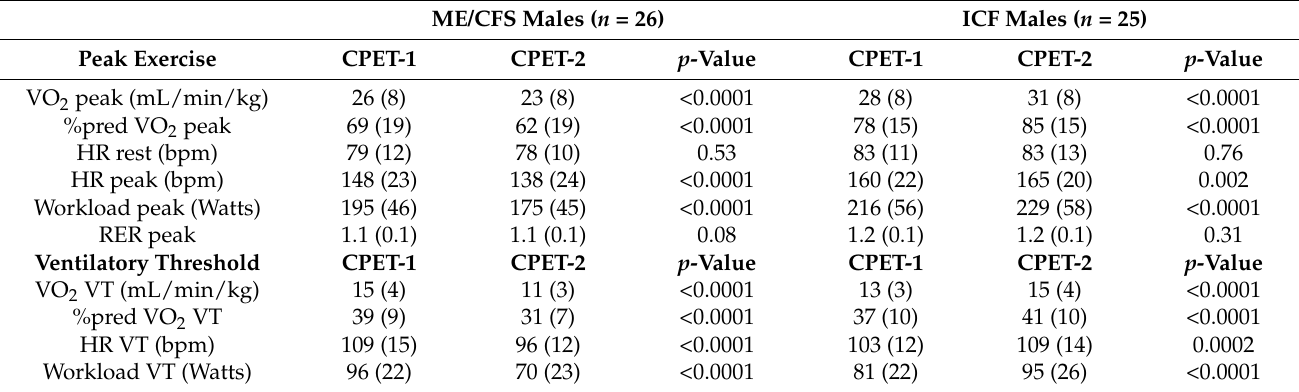
Table 2. CPET-1 and CPET-2 variables for male ME/CFS patients (left side) and male ICF patients (right side).